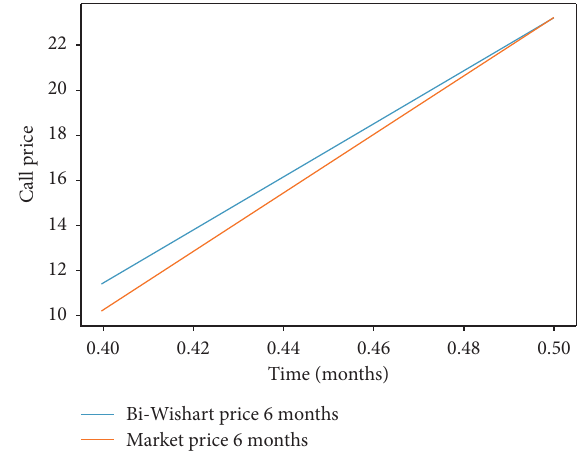
Figure 2: The call price predictions under the double Wishart model and market prices at 6 months maturity time.